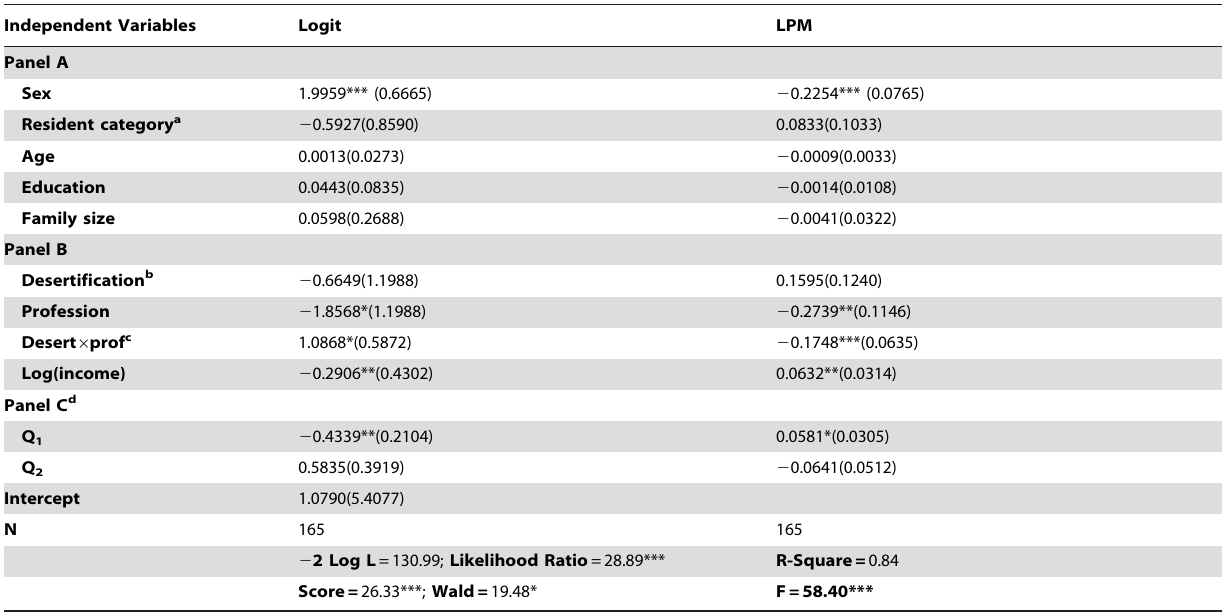
Table 3. Regression of V c